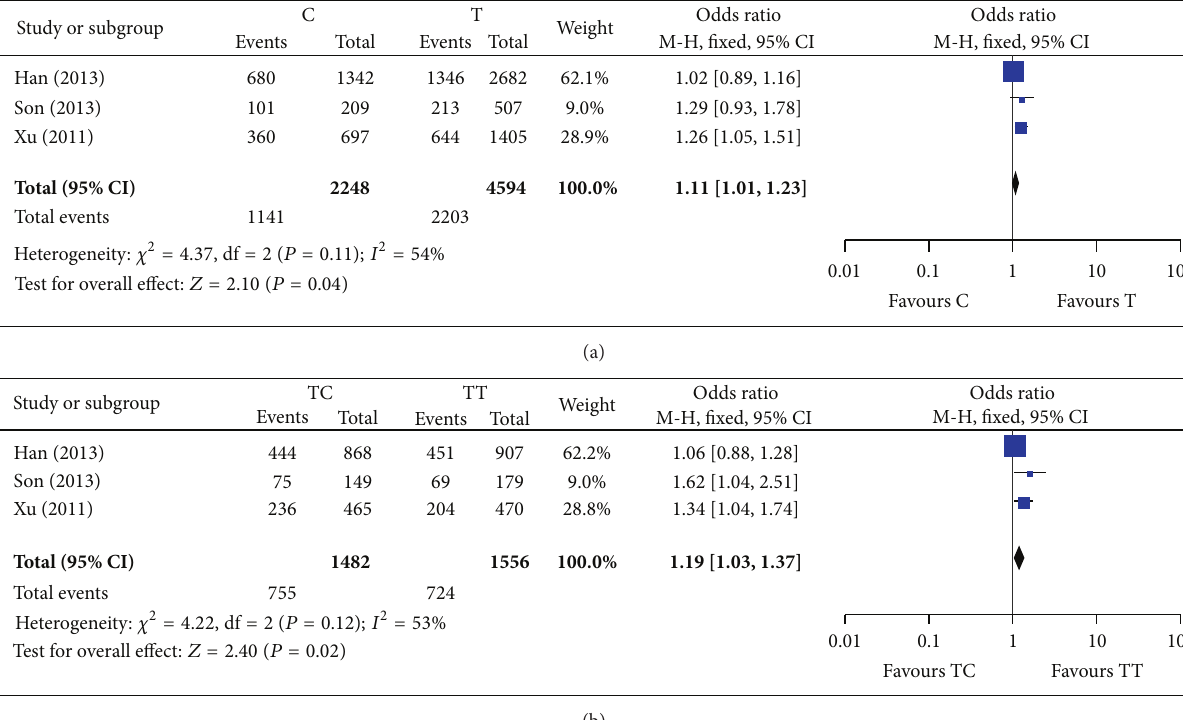
Figure 2: Forest plots of meta-analysis of association between rs4938723 and the risk of HCC. (a) Meta-analysis under allele frequency model. (b) Meta-analysis under heterozygous model. The blue squares and corresponding horizontal lines indicate odds ratio of individual study. The area of the squares reflects weight of indicated study. The black filled diamond represents pooled odds ratio and 95% confidence interval. significant associations were demonstrated in analyses under allele frequency (C versus T) and heterozygous model